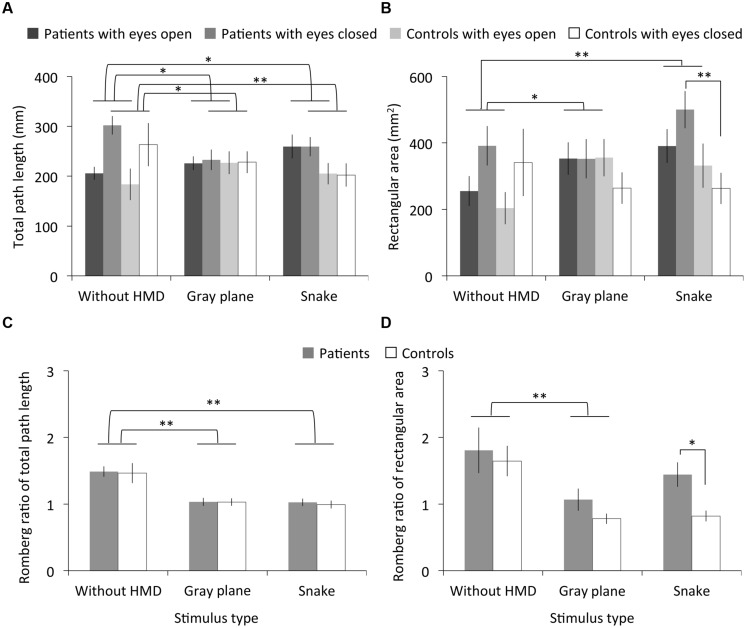
Results of Experiment 1. (A) Total path length, (B) rectangular area, and (C,D) their Romberg ratios for patients with migraine and normal controls as a function of stimulus type. Error bars denote ± 1 SEM. Asterisks indicate significant differences (∗p < 0.05, ∗∗p < 0.01).